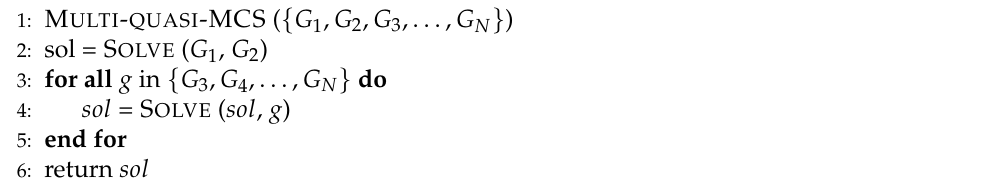
Figure 5. The waterfall approach: computing M ULTI - QUASI -MCS ( { G 1 , G 2 , . . . , G N } ) as MCS ( . . . , MCS ( MCS ( G 1 , G 2 ) , G 3 ) , . . . , G N ) . Algorithm 3 The trivial multi-graph, i.e., M ULTI - QUASI -MCS ( { G 1 , G 2 , G 3 , . . . , G N } ) , branch-and-bound